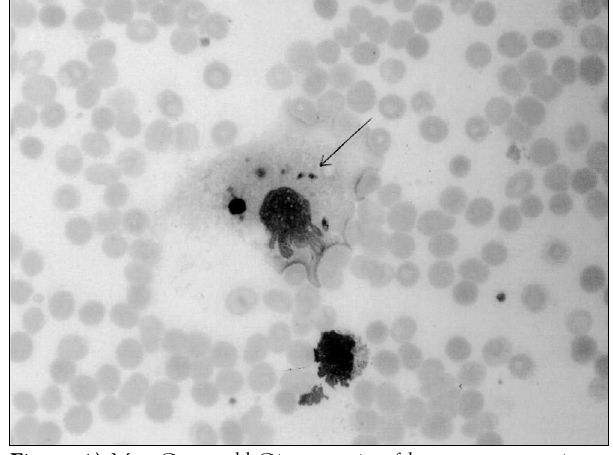
Figure 1) May-Grünwald-Giemsa stain of bone marrow aspirate, disclosing a mononuclear cell containing two Leishmania amastigotes (arrow) (Magnification ×